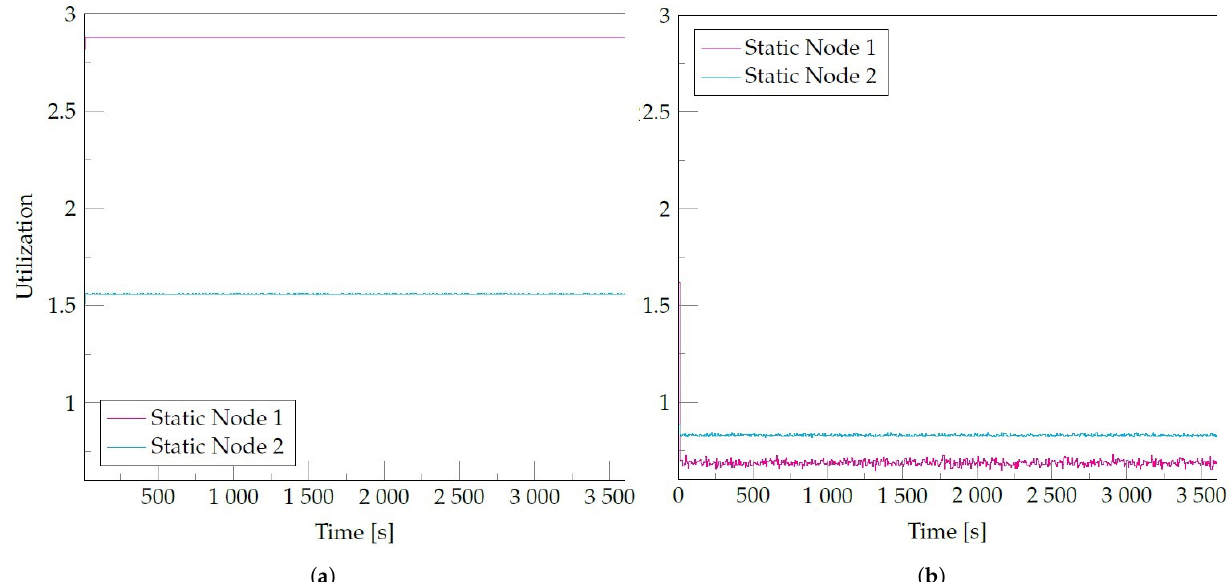
Figure 9. Cloud and Edge architecture statics nodes utilization over time. ( a ) Cloud Architecture. ( b ) SLedge Edge